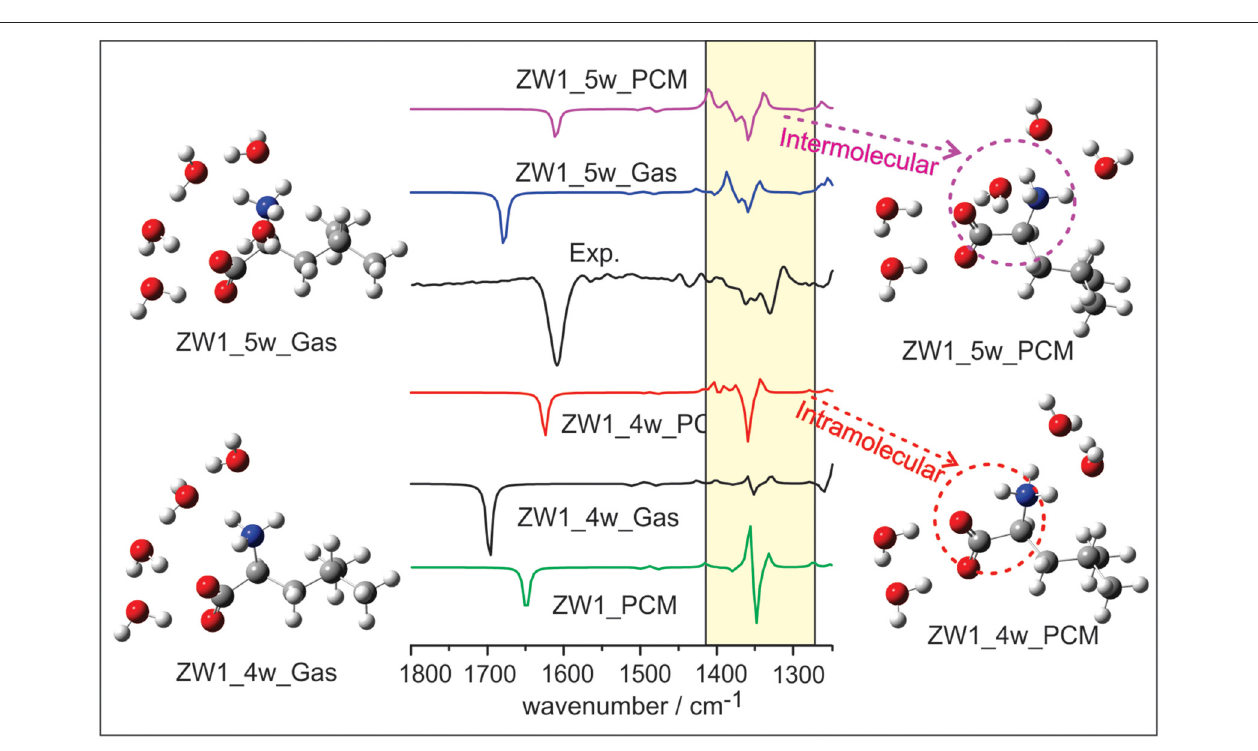
FIGURE 12 | The comparison of experimental VCD spectrum of leucine in water with the calculated ones of the leucine ZW1-5W and ZW1-4W complexes in the gas phase and in the PCM of water. Reproduced with permission from Poopari et al. (2012b). Copyright 2012, American Institute of